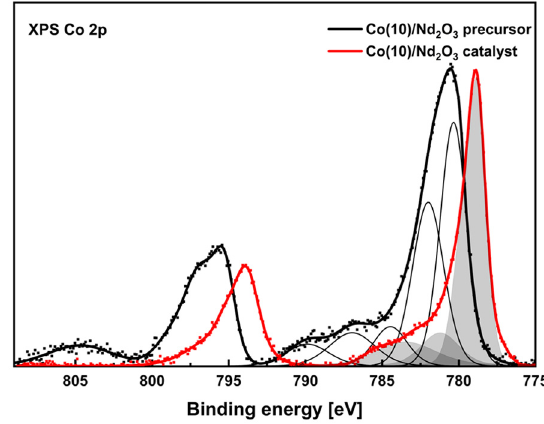
Figure 3. XPS Co 2p spectra of Co(10)/Nd 2 O 3 precursor and catalyst after reduction. The components of the Co 2p lines are marked with thin solid lines for the precursor and grey areas for the reduced catalyst.